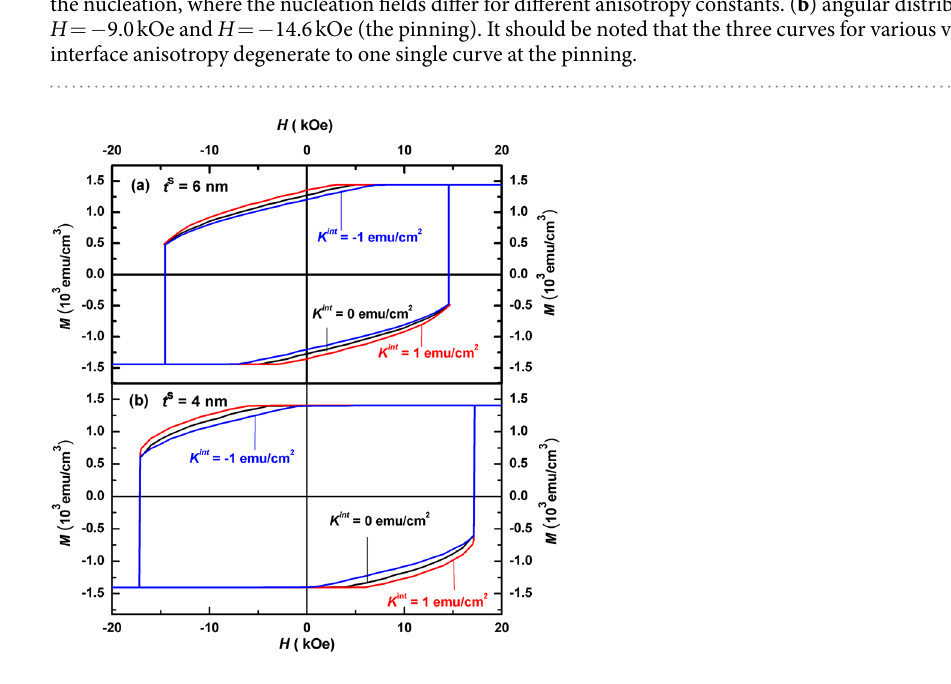
for K int = − 1 erg/cm 2 , 0 erg/cm 2 , and 1 erg/cm 2 , respectively. The increase of the ( BH ) max with the interface aniso- tropy is due mainly to the larger remanence M r , caused by the larger nucleation field.